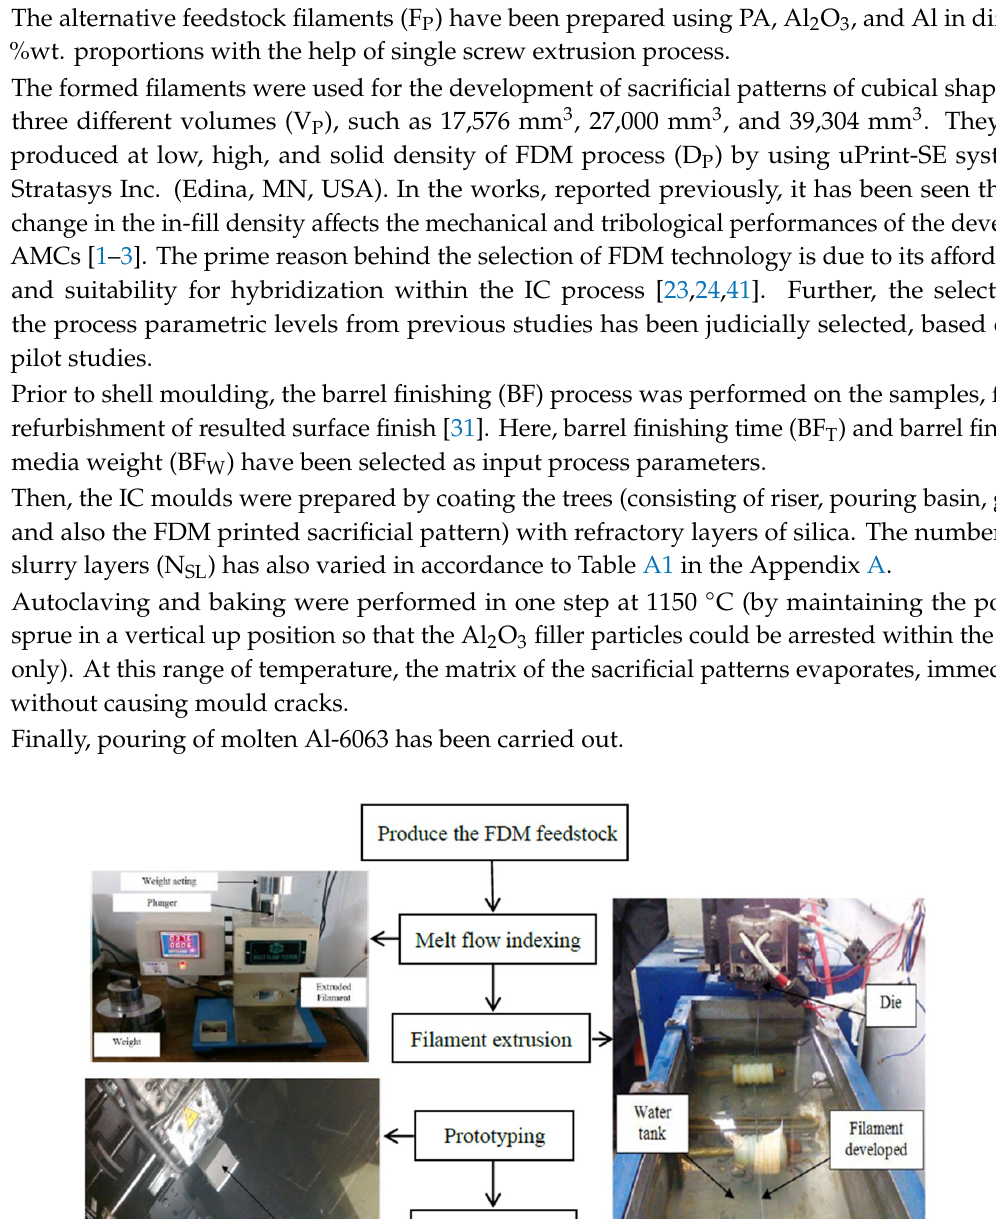
Figure 2. Fish bone diagram for prepared castings.